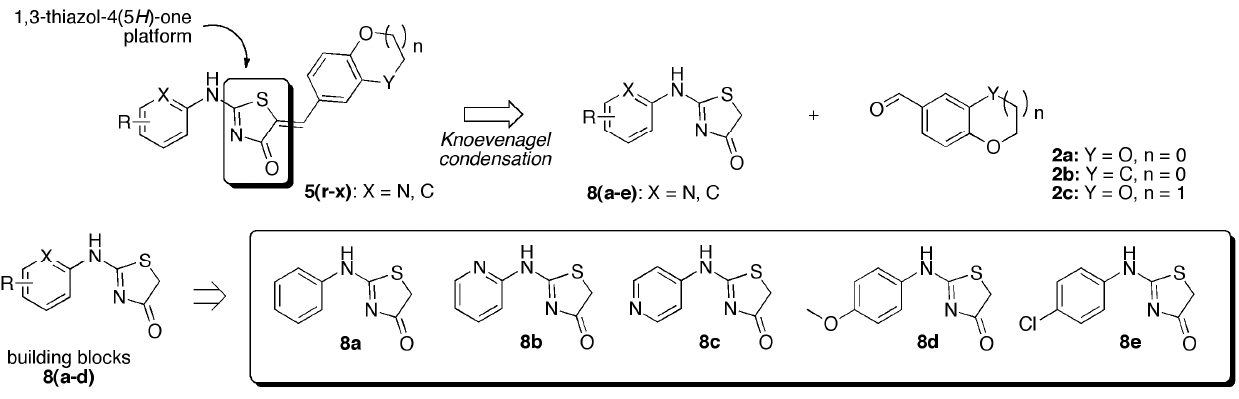
G003 Figure 3. Retrosynthetic strategy toward new (5 Z ) 2- N -heteroarylamino-5-arylidene-1,3-thiazol-4(5 H )-ones 5r – x based